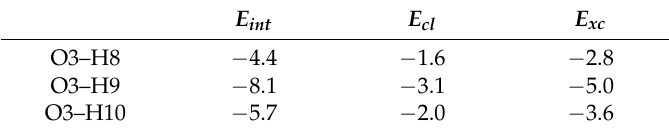
Table 2. B3LYP/6-31G(d) Total interaction energy (E int ) , classical energy (E cl ) and exchange–correlation energy (E xc ) , in kcal · mol − 1 , for the O3–H8, O3–H9, and O3–H10 interactions of small models TS1r and TS2r